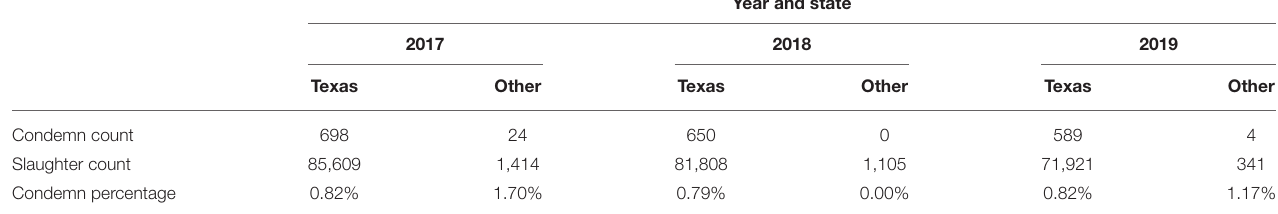
TABLE 2 | Feral swine total condemn and slaughter counts.